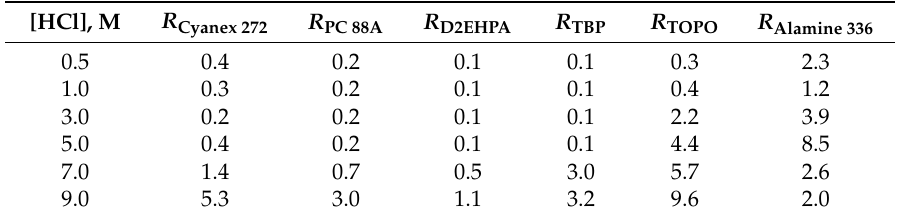
Table 8. Synergistic enhancement coefficient ( R ) of Pd(II) with mixture of 5,8-diethyl-7-hydroxyldodecane- 6-oxime (LIX 63) and various extractants.